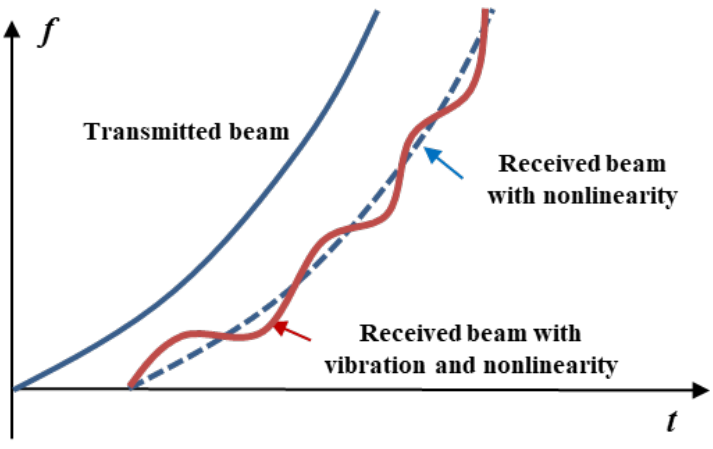
Then, we derive the influence of time-varying vibration coupled with nonlinearity on FMCW Lidar ranging. Figure 2 shows the influence of vibrations and nonlinearity on the ranging process. As shown in Figure 2, the transmitted beam contains nonlinear frequency, while the received beam contains both the nonlinear frequency and the Doppler frequency introduced by vibration. Therefore, the instantaneous phase of the dechirp signal is related not only to the nonlinearity of the transmitted signal but also to the Doppler frequency introduced by the vibration error [32].